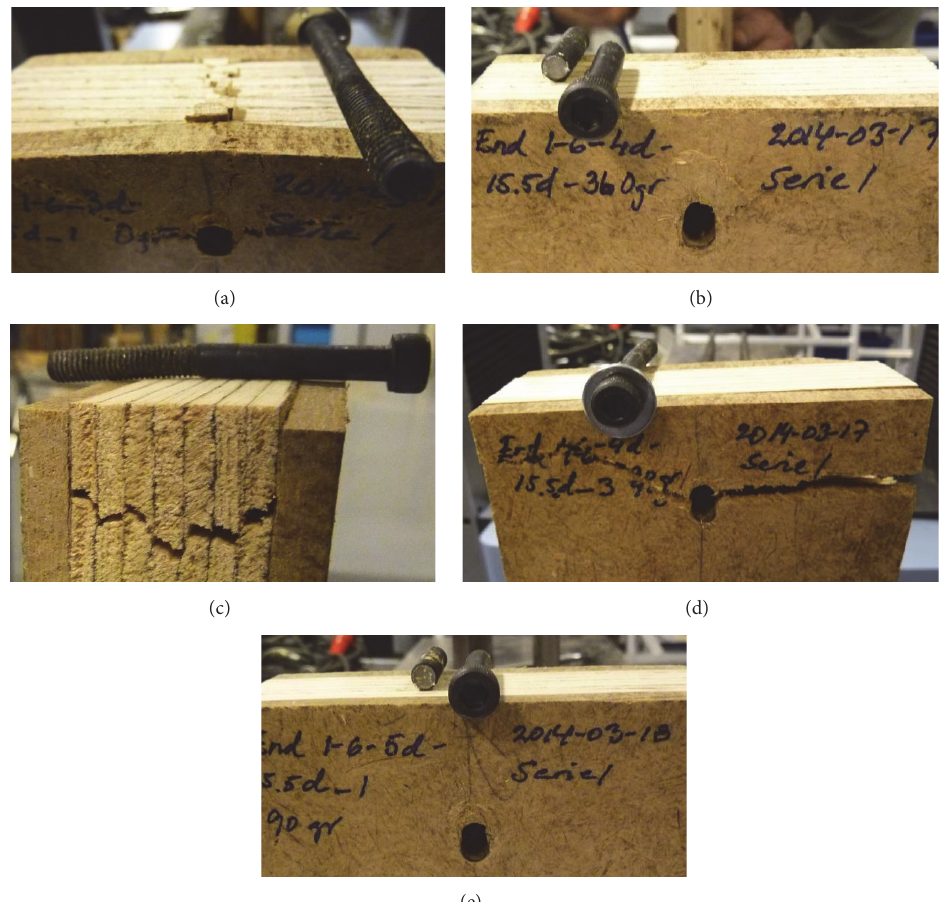
Figure 13: Typical failure modes for the different configurations for tests parallel (a, b) and perpendicular (c, d, e) to grain: (a) in the wood ≤ 3𝑑 , the main failure was plug shear failure in the LVL core; (b) in the screw failure range 𝑎 failure range 𝑎 end ≤ 3𝑑 , the main failure was in tension in the LVL core and in shear at the hardboard-LVL interface; bending; (c) in the wood failure range 𝑎 end ≥ 4𝑑 , the main failure was in tension both in the LVL core and in the hardboard layers; and (e) in the screw (d) in the wood failure range 𝑎 end ≥ 5𝑑 , the screw failed in failure range 𝑎 end